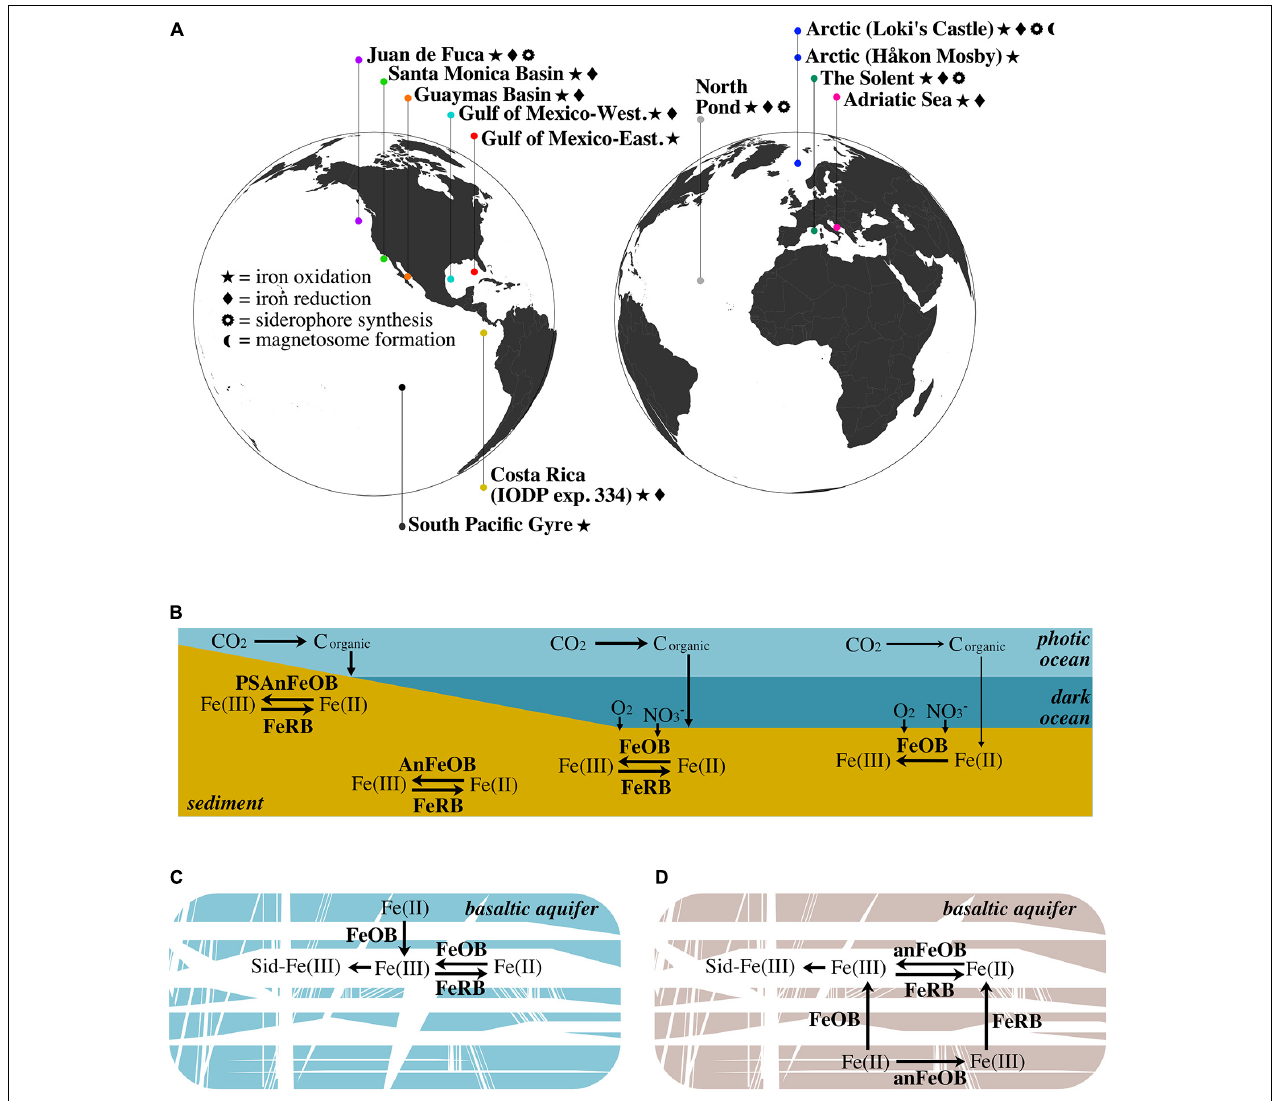
FIGURE 3 | (A) Geographic distribution of marine aquifer and sediment sites from which metagenome samples are derived. (B) Schematic of the iron redox cycle in various types of marine sediment. In shallow sediment within the photic zone (e.g., The Solent), photoferrotrophy can drive iron oxidation. Below the photic zone, aerobic iron oxidation in surficial sediment (e.g., Guaymas Basin, Santa Monica Basin, and Western Gulf of Mexico) is contrasted with anaerobic iron oxidation (e.g., nitrate-dependent) in deep anoxic sediment (e.g., Costa Rica and Loki’s Castle). In these aforementioned sediments, iron reduction is present and represents the other half of the iron cycle. Conversely, in oxic sediments, such as those underlying areas of low productivity (e.g., South Pacific Gyre), aerobic iron oxidation is the dominant process, with no detectable iron reduction. The lower productivity is denoted by thinner arrows that signify carbon fixation and sedimentation. (C) Iron cycling within the cold and oxic North Pond aquifer: iron is released from the young, largely ferrous (Bach and Edwards, 2003), basaltic crust via iron oxidation, where it is free to cycle between the ferric and ferrous forms, and subject to the chelating activity of siderophores. (D) Iron cycling within the warm, anoxic JdF aquifer: since the waters circulating in this aquifer are anoxic, iron oxidation is likely dependent on anaerobic metabolisms. Similar to North Pond, JdF basaltic crust is young and the iron content is largely ferrous (Bach and Edwards, 2003); thus, iron is first released via oxidation. Detection of iron reduction on the surface of